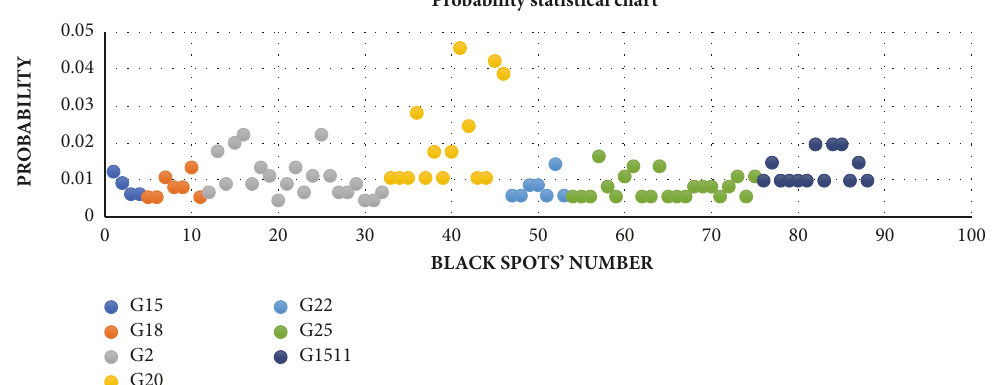
Figure 4: Probability statistical